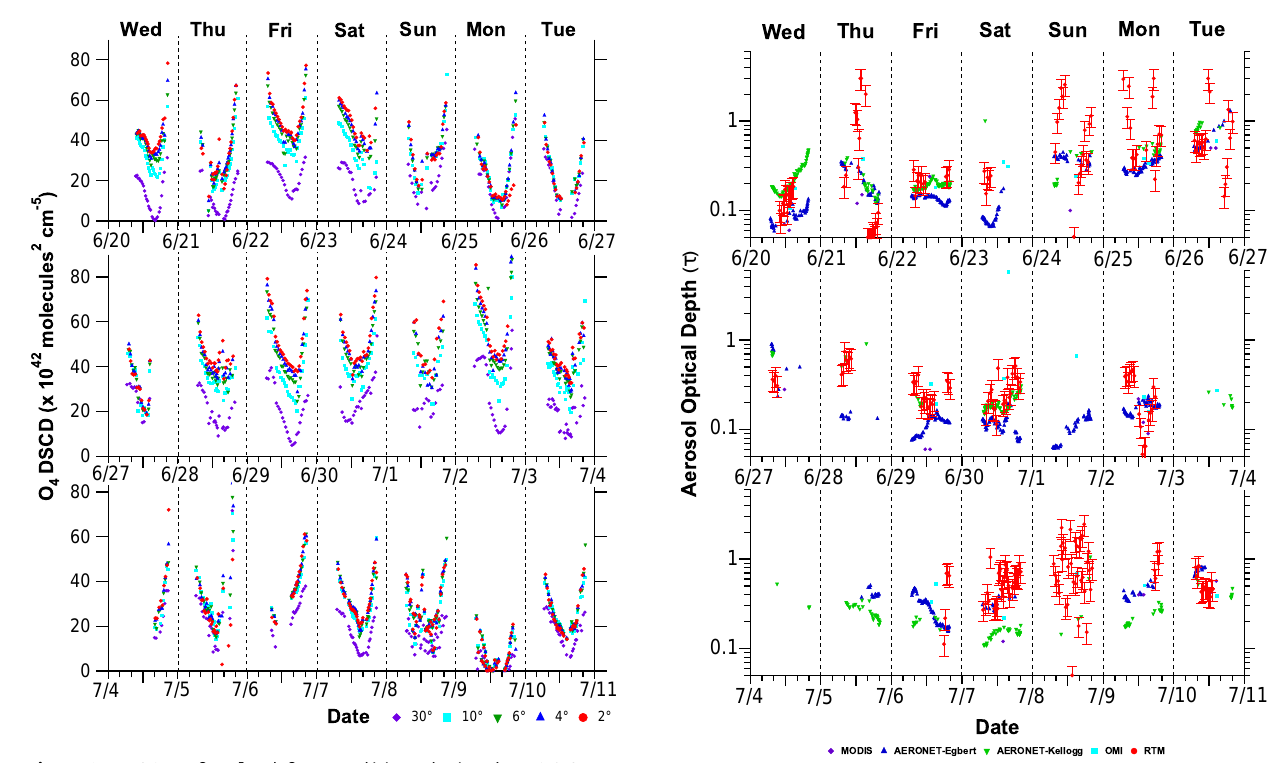
Fig. 5. Aerosol optical depth for the entire BAQS-Met cam- paign. For AERONET locations (Egbert, Kellogg) λ avg = 360nm, for coincident satellite measurements (OMI λ = 388nm, MODIS λ = 550nm), and for the MAX-DOAS-RTM values at Ridgetown, λ =